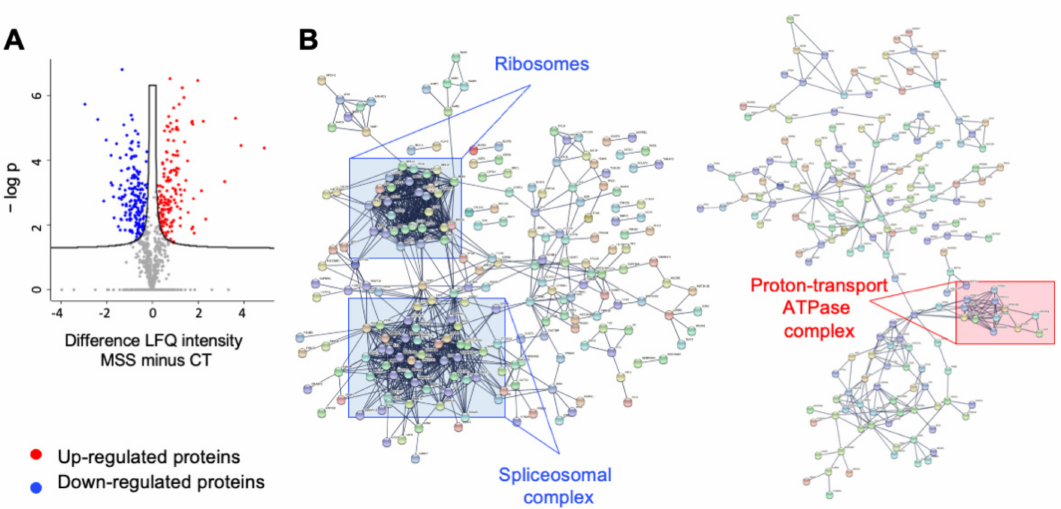
Figure 4. Proteomic analysis graphical networks. ( A ) Volcano Plot: Statistical analysis of differentially expressed proteins between HF-CT and HF-MSS cells, run by Perseus. LQF intensity of HF-MSS minus that of HF-CT was plotted against the negative logarithm of the p -values. ( B ) STRING network of proteins downregulated (left) and upregulated (right) in HF-MSS, confidence level set at 0.9. Squares indicate examples of clusters of interacting proteins involved in the indicated